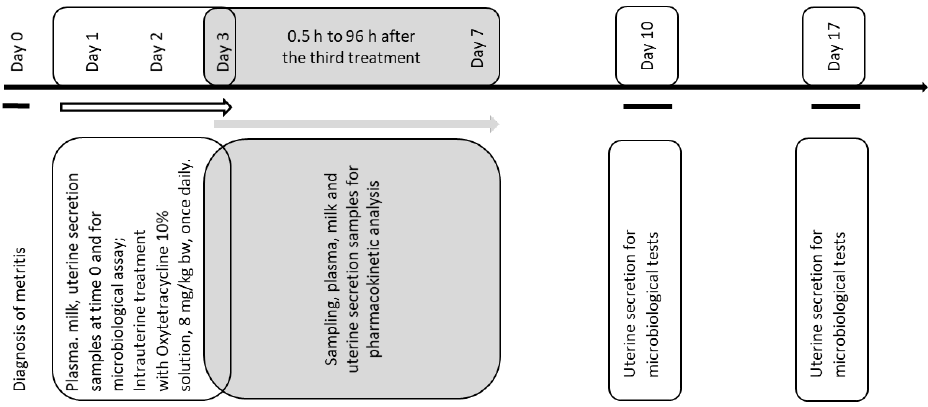
Figure 1. Experimental design of the study with timeline of the treatments and sampling.